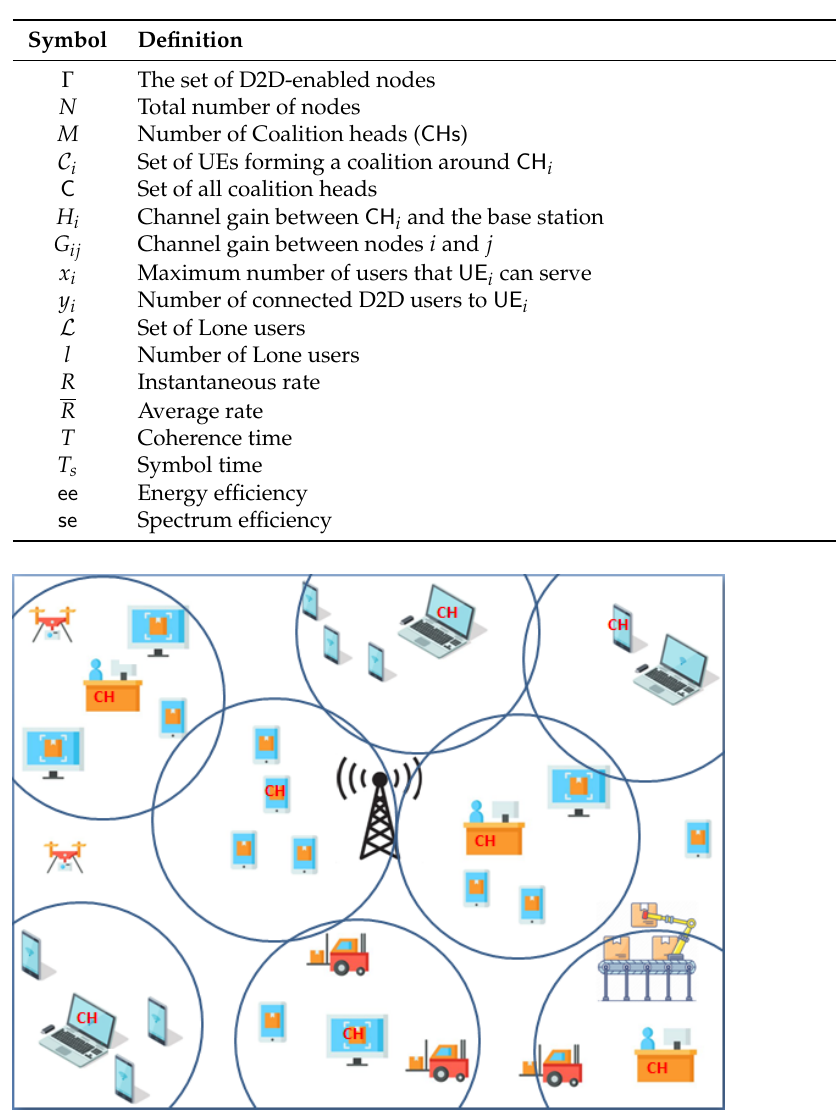
Figure 1. Illustration of the system